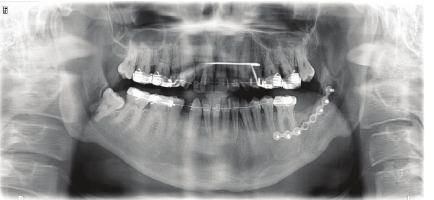
Figure 5: Postoperative control radiography after 6 months of healing